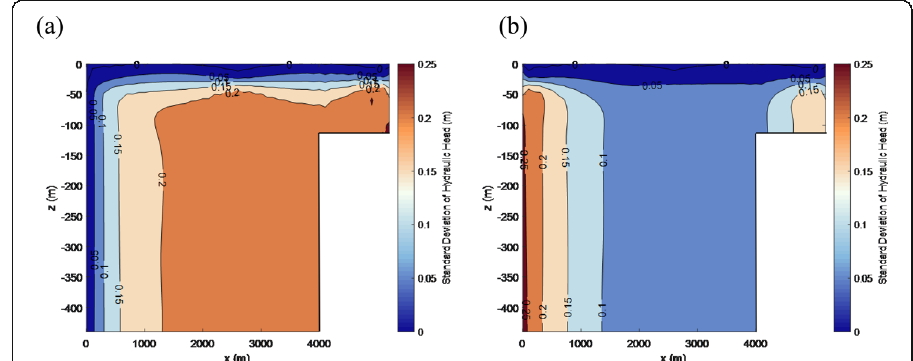
Fig. 15 Effects of the boundary conditions on the uncertainty of hydraulic head considering the spatial variability of k a ( l x = 200 m, l z = 40 m, COV = 0.8). a Hydraulic head boundary condition. b Flux boundary